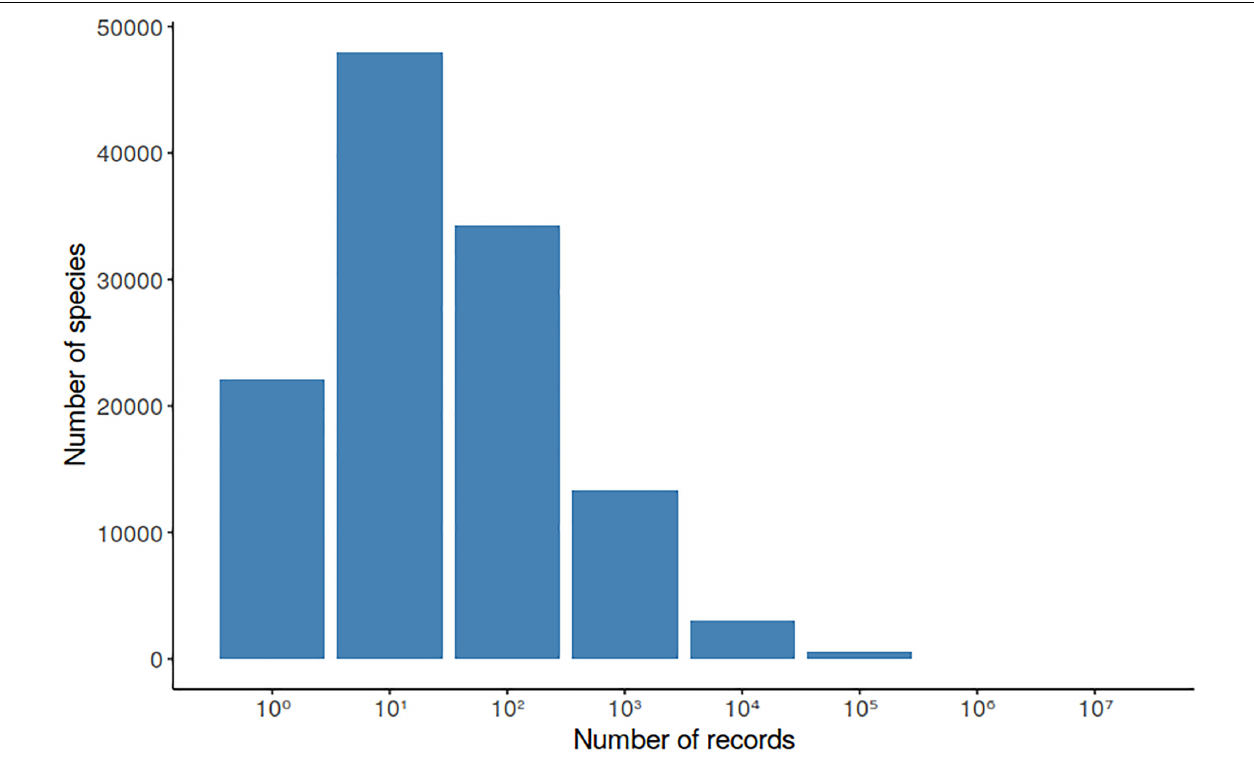
FIGURE 2 | Number of taxa identified at species level in OBIS by number of records in the database. More details about the distribution of the records by taxa and statistics on quality issues can be found on the OBIS statistics page, which is updated with every new record published in OBIS (https://obis.org/statistics).